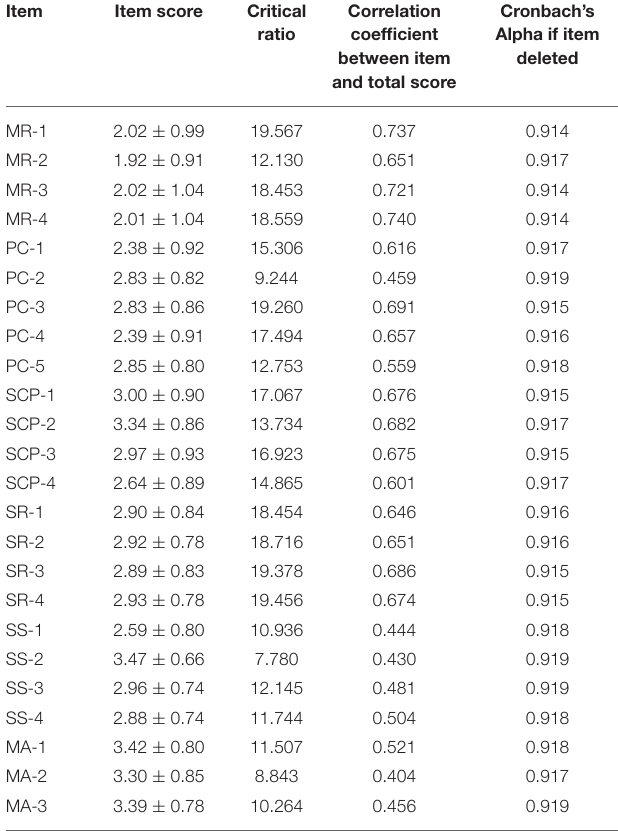
TABLE 2 | Item analysis for Chinese version of the